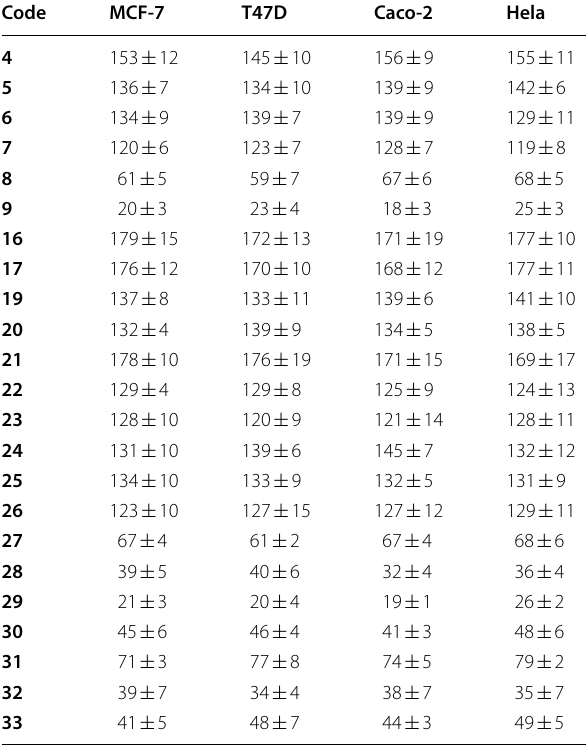
Values are expressed as mean